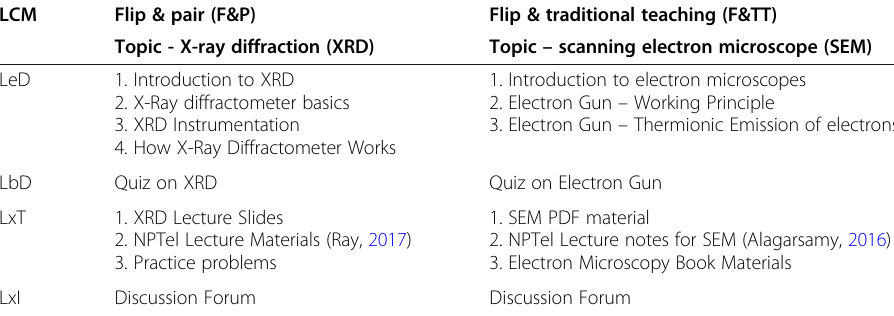
Table 2 Target materials used for the analysis for F&P and F&TT strategy LCM Flip & pair